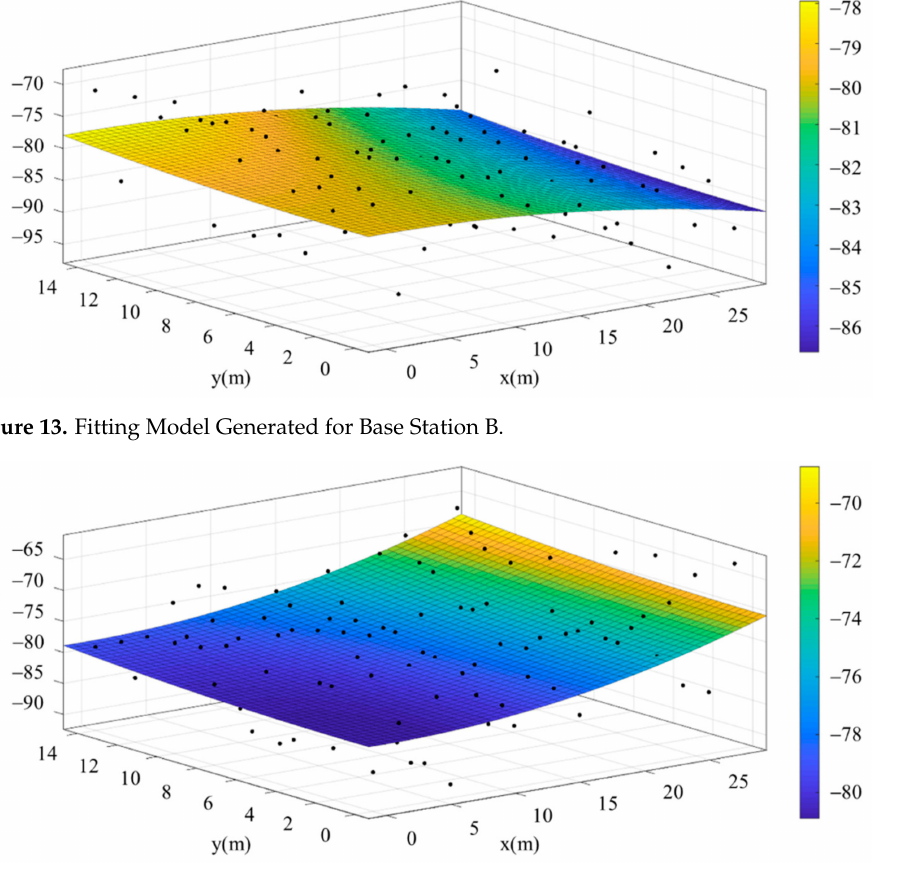
Figure 14. Fitting Model Generated for Base Station C.